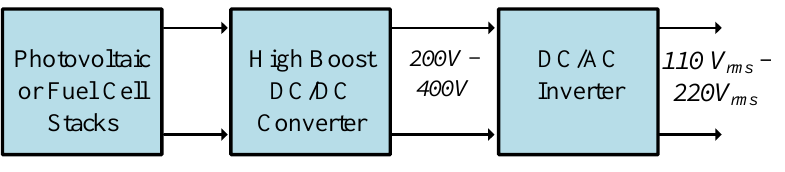
Figure 1. Power-conversion system.